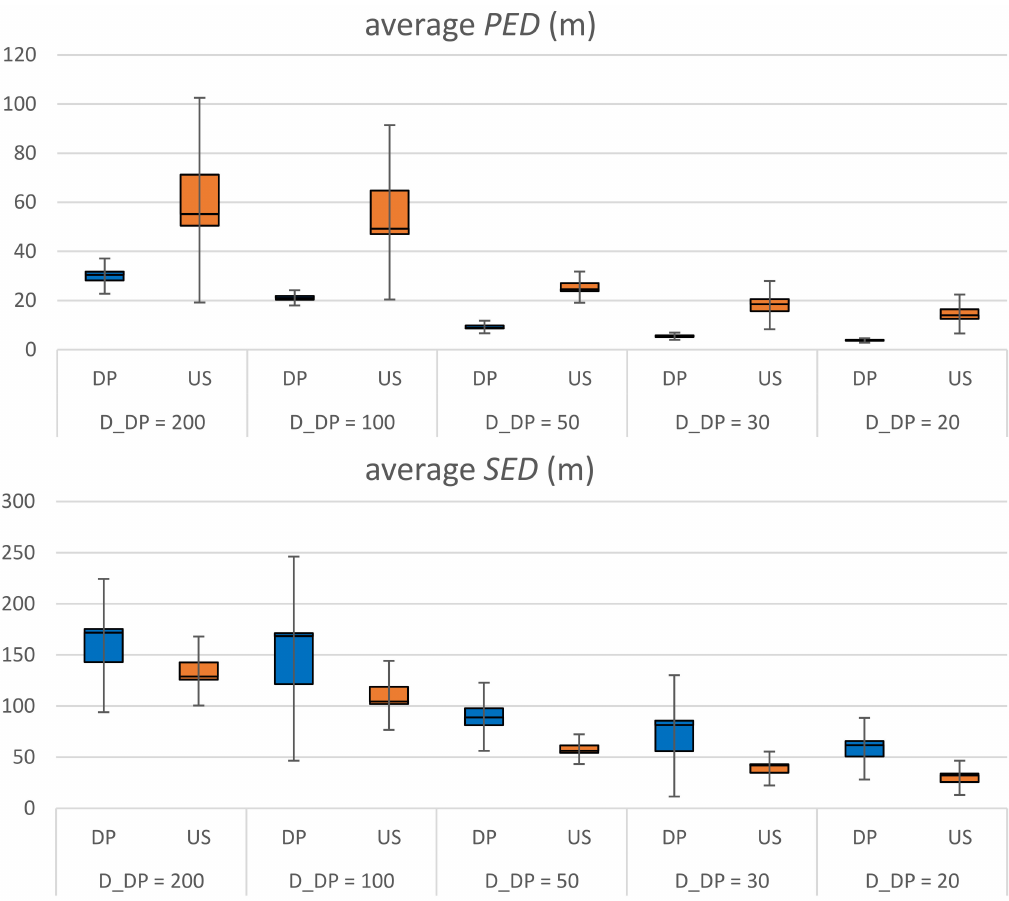
Figure 7. Performance comparison of Douglas–Peucker (DP) and uniform sampling (US) algorithms.